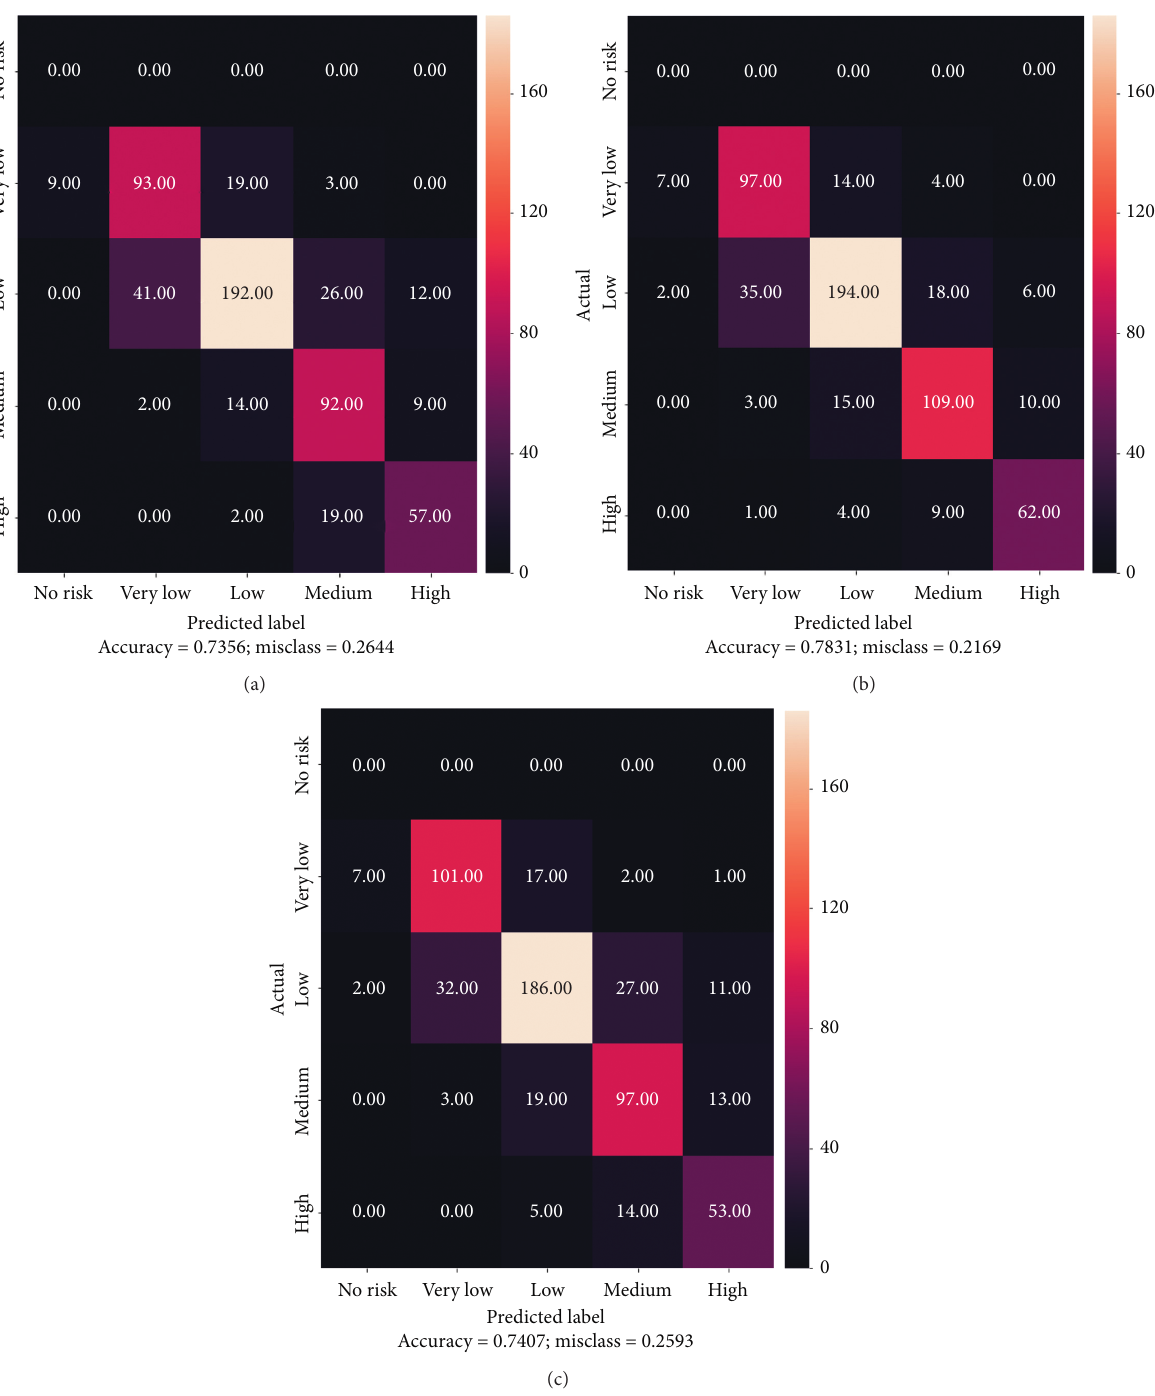
Figure 8: Severity confusion matrix. MobileNetV2 (a), EfficientNetB0 (b), and InceptionV3 VGG-16. Table 4 details the training time required for each model.